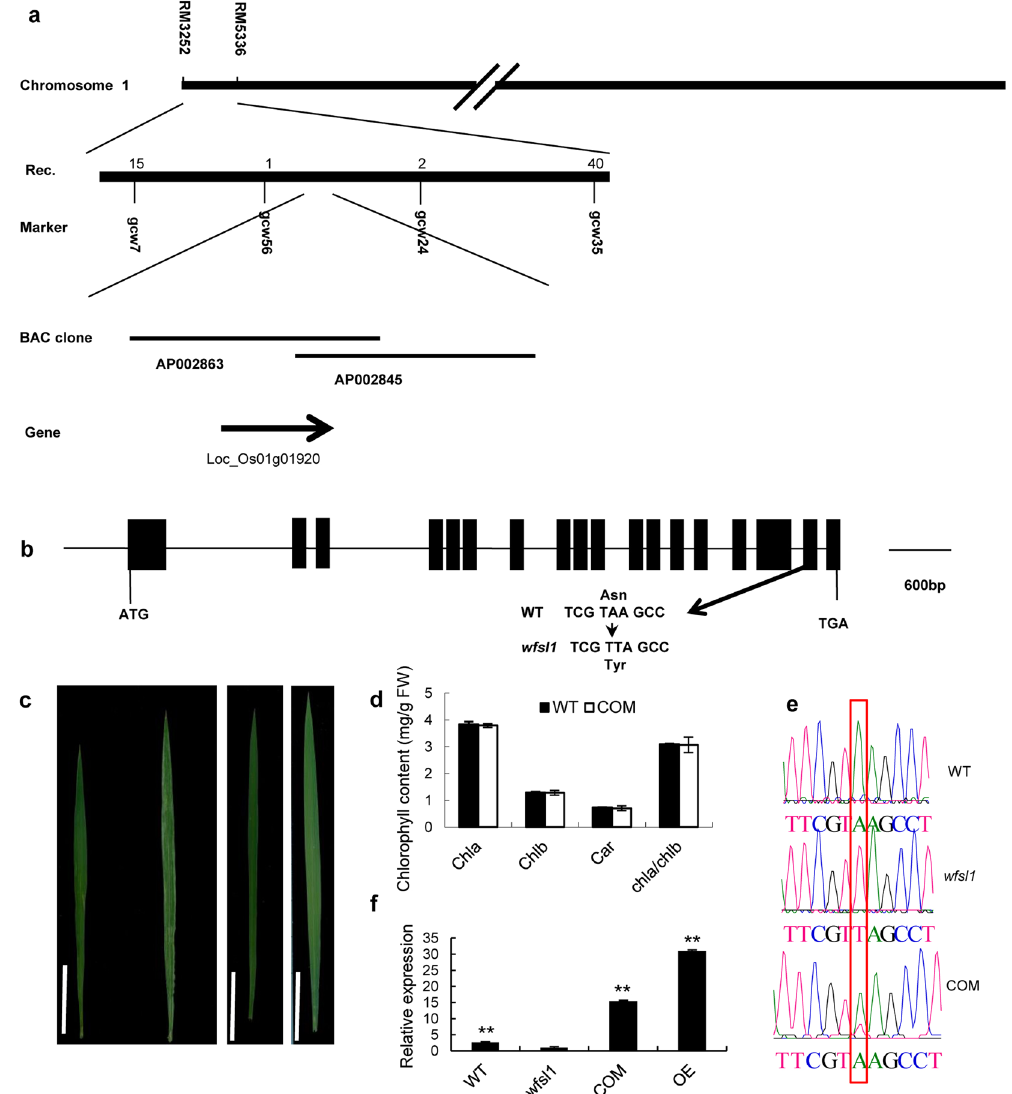
Figure 4. Map-based cloning of the WFSL1 gene. ( a ) Fine mapping of WFSL1 . Markers used for mapping are indicated. AP002863 and AP002845 are accession of BACs. ( b ) Structure of WFSL1 . ATG and TGA represent the start and stop codons, respectively. Black boxes indicate the exons and the lines indicate introns. A single nucleotide replacement ‘A’ to ‘T’ led to an amino acid change. ( c ) Leaf phenotype at tillering stage wild type and wfsl1 (left), complementation plants (COM) (middle), overexpression plants (OE) (right). ( d ) The chlorophyll content of wild type and complementation plants at tillering stage. ( e ) Sequencing results indicate wild type genome DNA fragment transfer into wfsl1 plants. ( f ) The expression level of wild type, wfsl1 , complementation and overexpression at tillering stage. The relative expression level of wfsl1 represents “1” Data are mean ± SD (n = 3). Bars: ( c ) 5 cm. Error bars represent the SD from three independent experiments.(Student’s t -test, * P < 0.05; ** P <